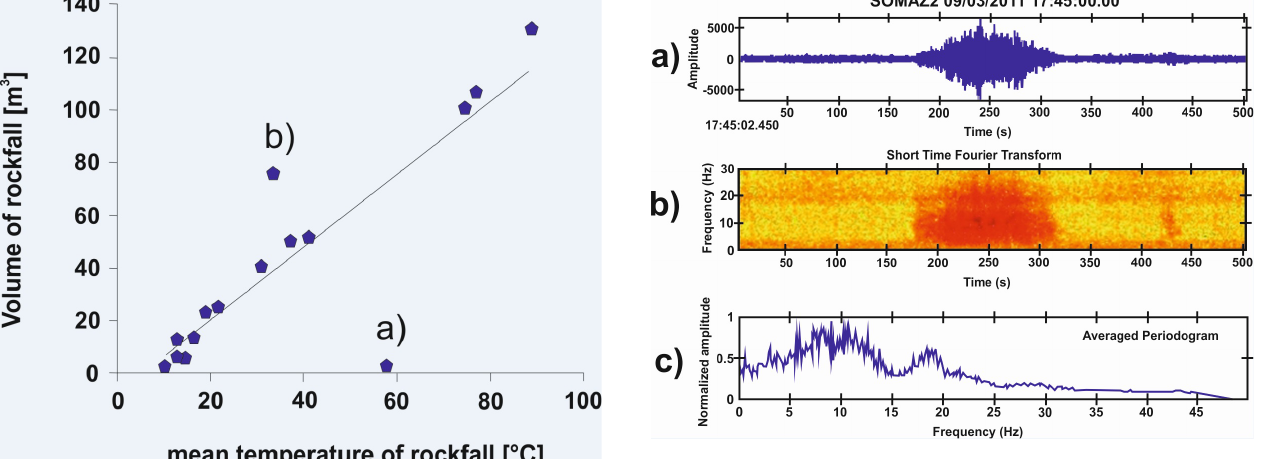
Fig. 8. Rockfall signal at Volc´an de Colima with its frequency. Shown are (a) the seismogram and (b) its time-frequency repre- sentation and (c) the averaged periodogram of the event. An order 2 high-pass filter was applied with a low corner frequency of 1Hz. The rockfall was recorded at SOMA station at 17:48 GMT on 9 March